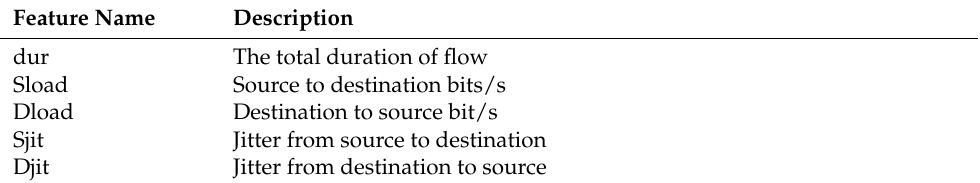
Table 3. Float-based